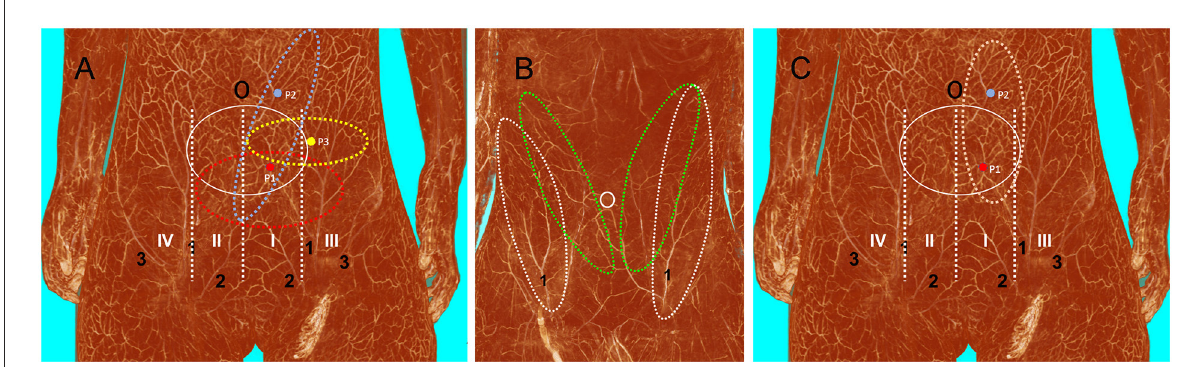
FIGURE5 Three-dimensional visualization of the abdominal wall. (A) Blood supply (white solid ellipse) from the deep inferior epigastric artery in a female cadaver after angiographic injection. If the perforator is located in zone I (P1), tissue from zones I, II, and III can be safely harvested using the transverse design (red dotted ellipse). If the perforator is located in zone III (P3), only tissue from zones I and III can be safely harvested using the transverse design (yellow dotted ellipse). Both P1 and perforator 2 (P2) can be used to harvest the oblique DIEP flap, but using P2 enables the harvest of a large amount of tissue with P2 at the center of the flap (blue dotted ellipse). (B) Anatomical basis of the oblique DIEP flap (green dotted ellipse) and SIEA flap (white dotted ellipse) in a male cadaver after angiographic injection. (C) Anatomical basis of the vertical DIEP flap. DIEP, deep inferior epigastric perforator; SIEA, superficial inferior epigastric artery; 1, superficial inferior epigastric artery; 2, superficial external pudendal artery; 3, superficial iliac circumflex